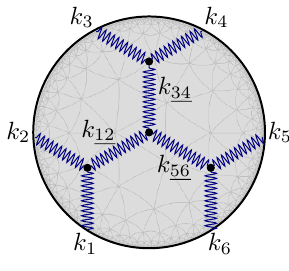
Figure 4 . The six point diagram out of star-triangle